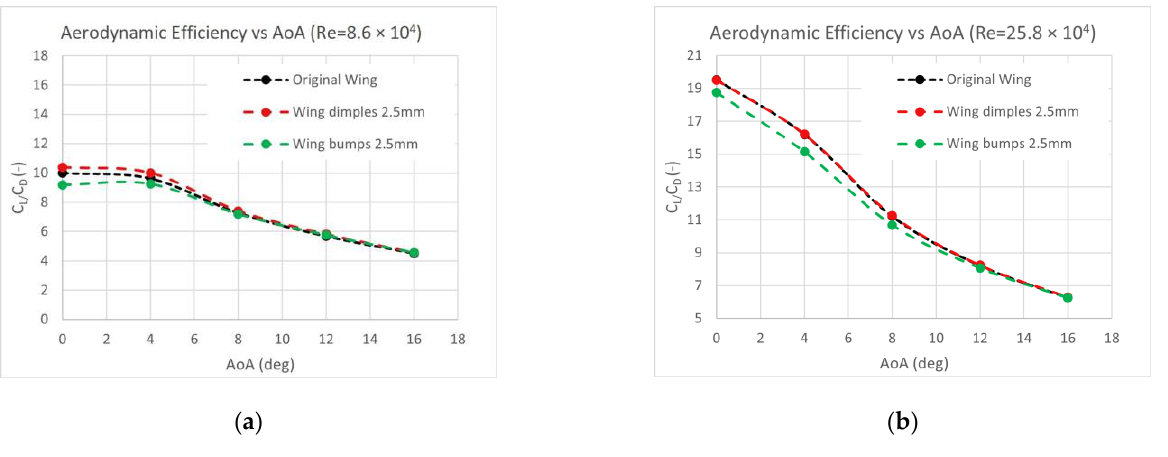
Figure 11. Lift-to-Drag ratio of the three wings under ( a ) Re = 86,000 and ( b ) Re = 258,000.